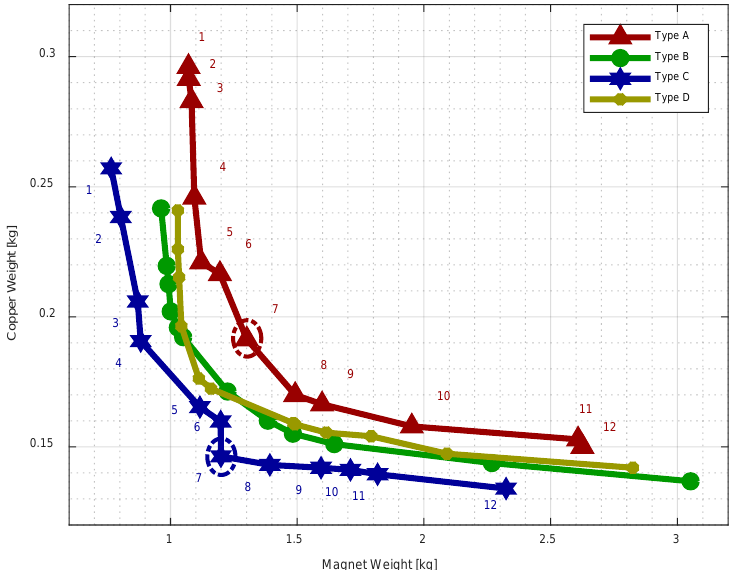
Energies 2018 , 11 , x FOR PEER REVIEW Figure 12. Pareto fronts obtained after the four optimization runs. Figure 12. Pareto fronts obtained after the four optimization runs.